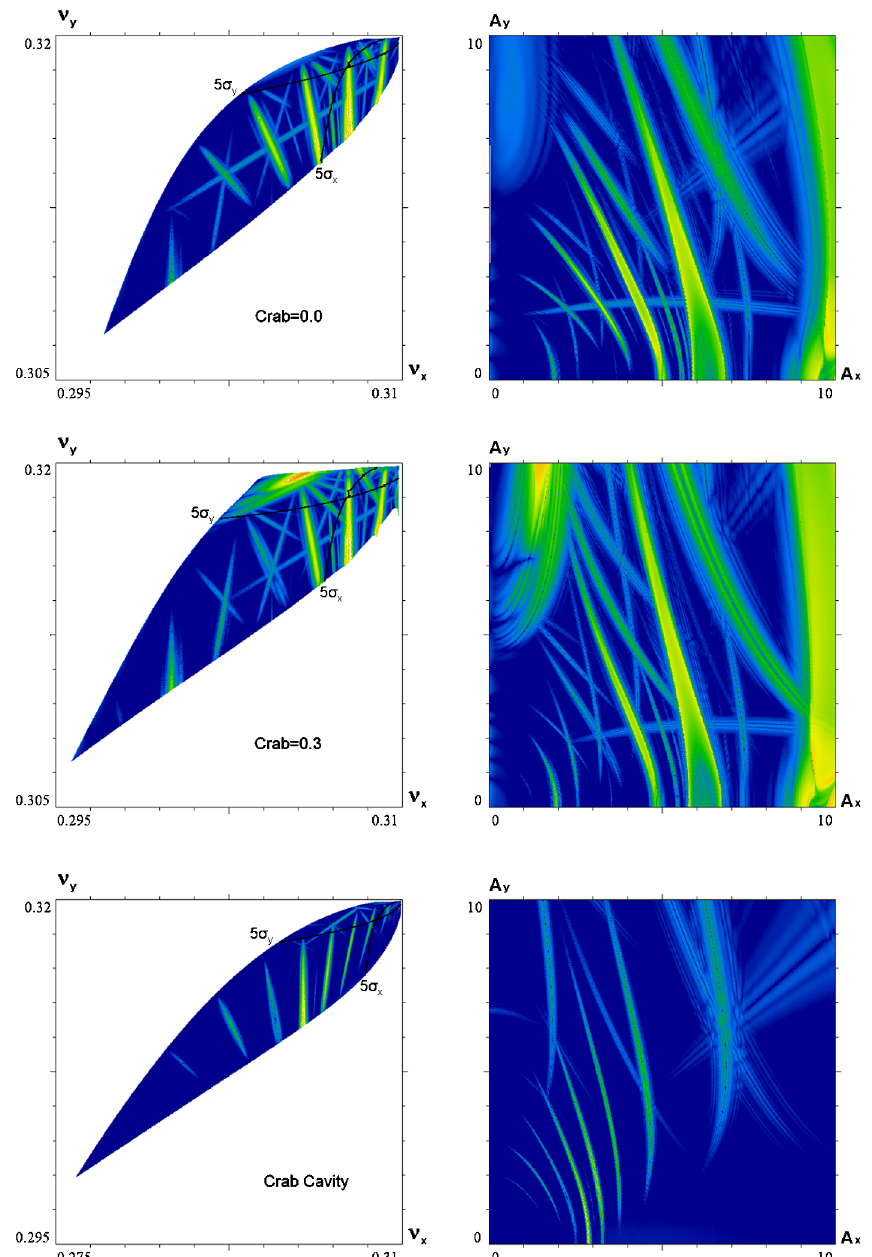
FIG. 11. FMA plots for LHC upgrade in the planes of betatron tunes (left) and normalized betatron amplitudes (right). The case without crabbing is shown on top, the optimum crab waist—in the middle, and crab crossing scheme—at the bottom. Black lines in the plane of tunes correspond to the normalized betatron amplitudes of 5